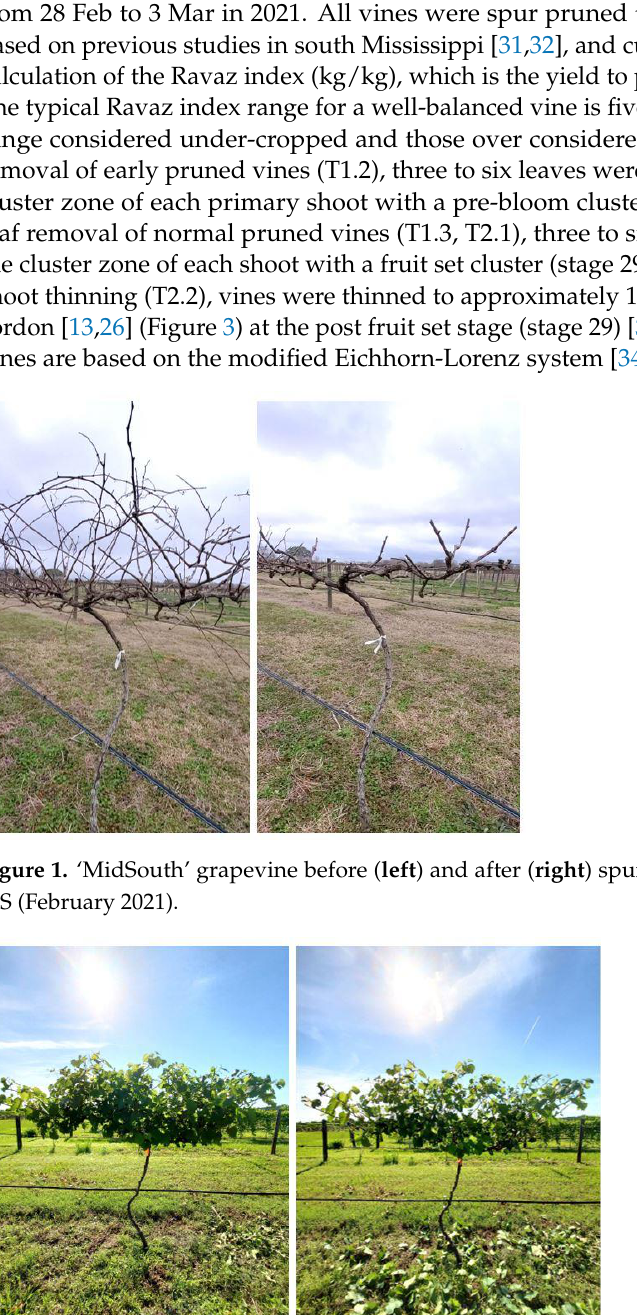
Figure 3. ‘MidSouth’ grapevine before ( left ) and after ( right ) shoot thinning to 15 primary shoots per meter in McNeill, MS (May 2021). The vines were sprayed with fungicide, alternating between Rally (active ingredient (a.i.): myclobutanil, Dow AgroSciences, Indianapolis, IN) at a rate of 0.29 L (0.12 L a.i.) per ha and Manzate Pro-Stick (a.i.: mancozeb, United Phosphorous Inc, King of Prussia, PA) at a rate of 3.08 kg (2.31 kg a.i.) per ha, beginning in late March and every two weeks until just before veraison (stage 35) [34] (early June) for fungal disease management of anthrac- nose ( Elsinoe ampelina (de Bary) Shear) and black rot ( Phyllosticta ampelicida (Engelm.) Aa) [31,35]. Finale (a.i.: glufosinate, BASF Corp, Research Triangle Park, NC) herbicide was applied at a rate of 9.35 L (1.06 kg a.i.) per ha two times in the season for weed control, and granular 13-13-13 fertilizer (N-P-K, Agri-AFC LLC, Decatur, AL) was applied by hand at a rate of 0.4 kg per vine in two applications: once in late March and again in early June [31,36]. In both studies, from veraison until harvest, weekly TSS, TA (primarily tartaric acid), and juice pH values were based on hand-picked samples of 20 berries per vine and deter- mined using a Pocket Brix-Acidity Meter (PAL-BX|ACID 2, Atago Co. Ltd., Tokyo, Japan) and titration with a NaOH solution using an automatic mini titrator (HI84502U-01, Hanna Instruments, Woonsocket, RI). All vines were hedged to 0.3 to 0.6 m above the top wire before harvest to remove excess vegetative growth and detangle shoots for an easier har- vest. Daily temperatures were collected to calculate the number of growing degree days (GDD) throughout the growing season in each year. The equation for calculating GDD was daily maximum temperature + minimum temperature/2 – base temperature, with the base temperature set at 10 °C.